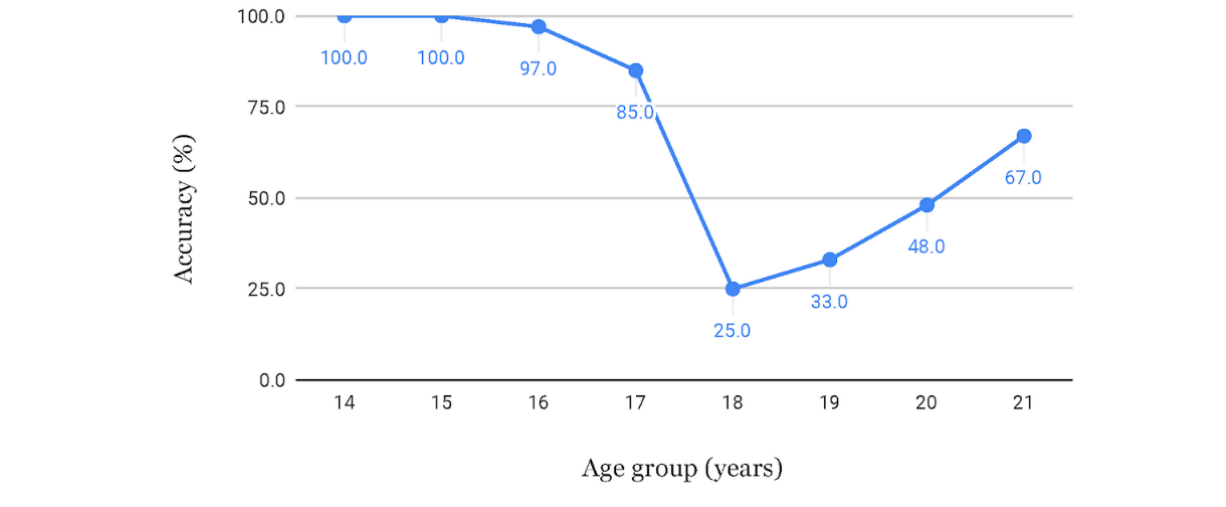
Figure 11. Accuracies for minor versus adult classification of female subjects, using threshold to increase accuracy for minors.